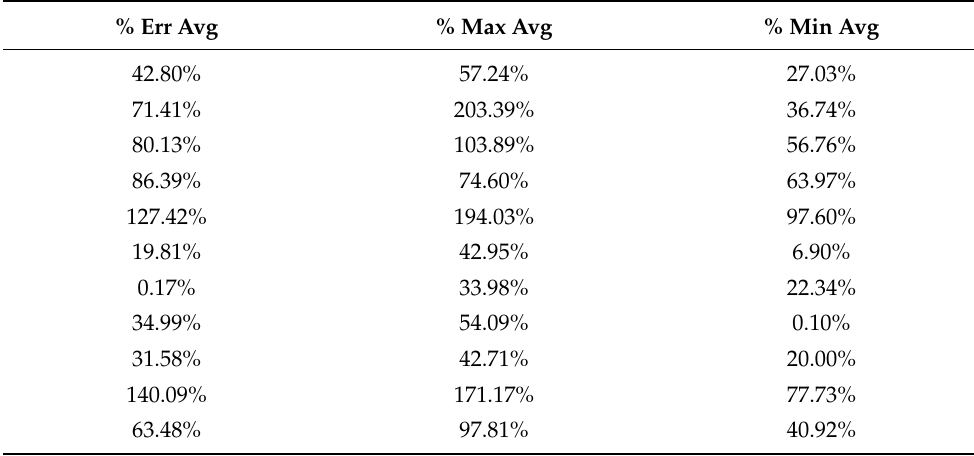
Table A228. Set 3, trials 41–50 data (average actual PR values).